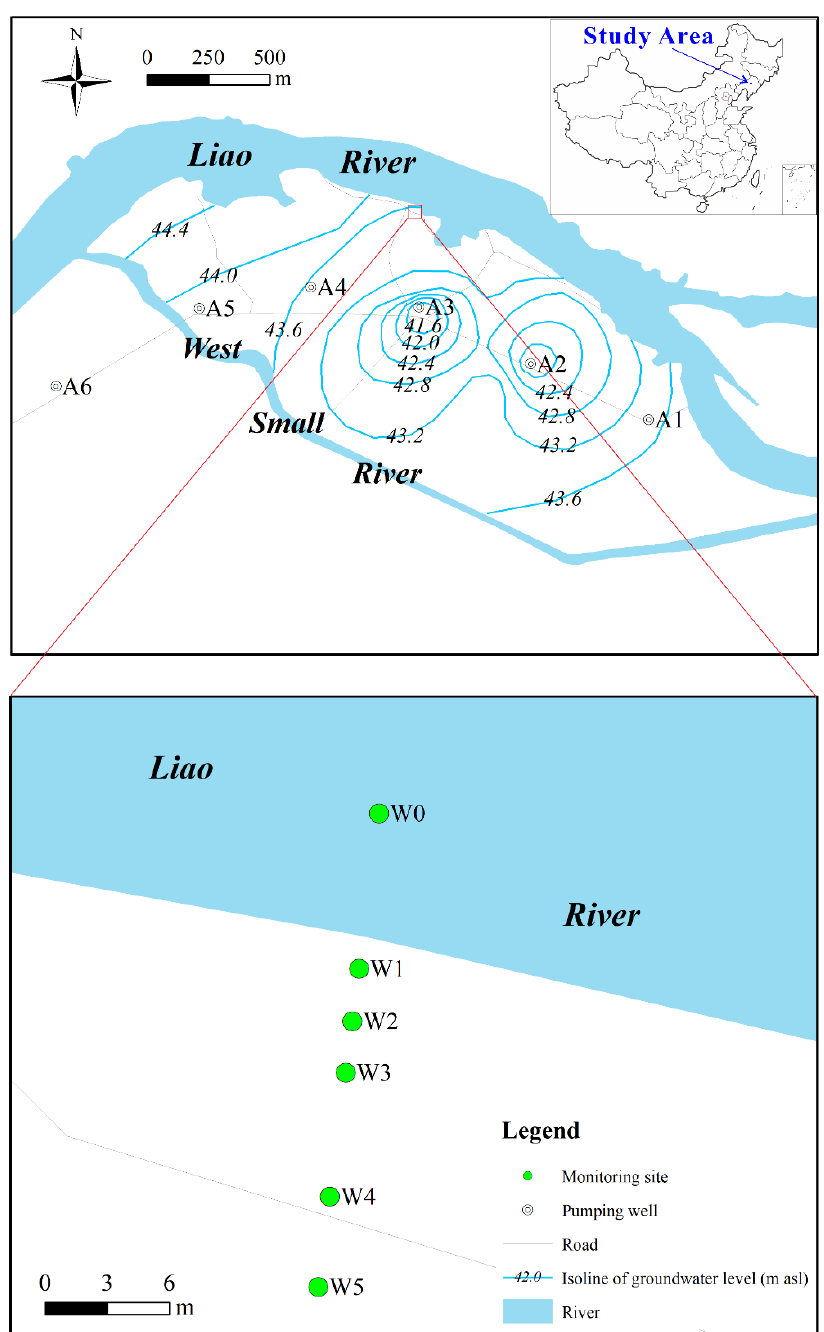
Figure 1. Location of the study area and distribution of monitoring sites.